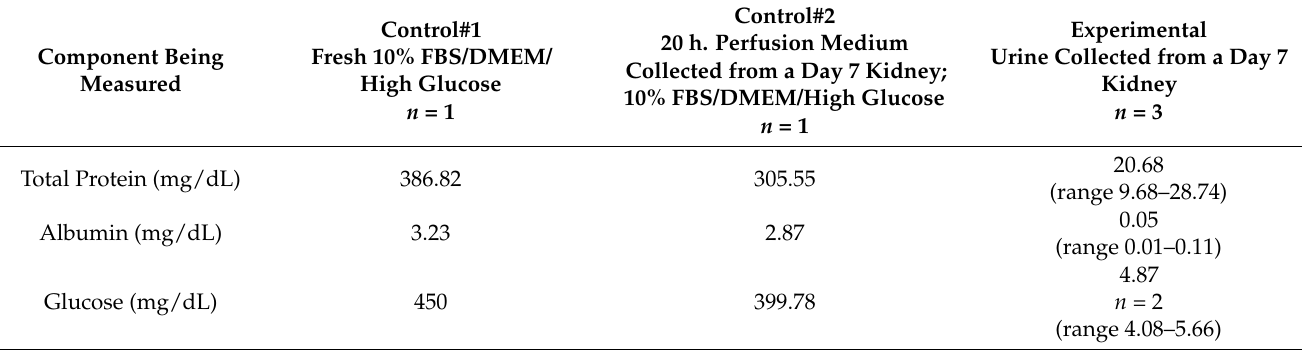
Table 1. Urine analysis. Urine was collected from the ureter cannula at day 7 from kidneys analyzed and compared to fresh high glucose DMEM medium and the medium in the reservoir at the time of the urine collection (20 h). The average of the reading and the range of the readings is presented. The live kidneys consumed protein and glucose during normal kidney metabolism as observed by the decrease in total protein, albumin and glucose values of the fresh medium compared to the medium in the reservoir at t = 20 h. In the glomeruli glucose and protein will pass from the perfusion medium (‘blood’) to the ultrafiltrate (‘urine’) but then be reabsorbed by the proximal tubule cells. In a healthy kidney almost all the protein and glucose is reabsorbed back into the blood. This is seen here with the levels of protein and glucose in the collected urine (Experimental) being much lower than the perfusion medium (Control